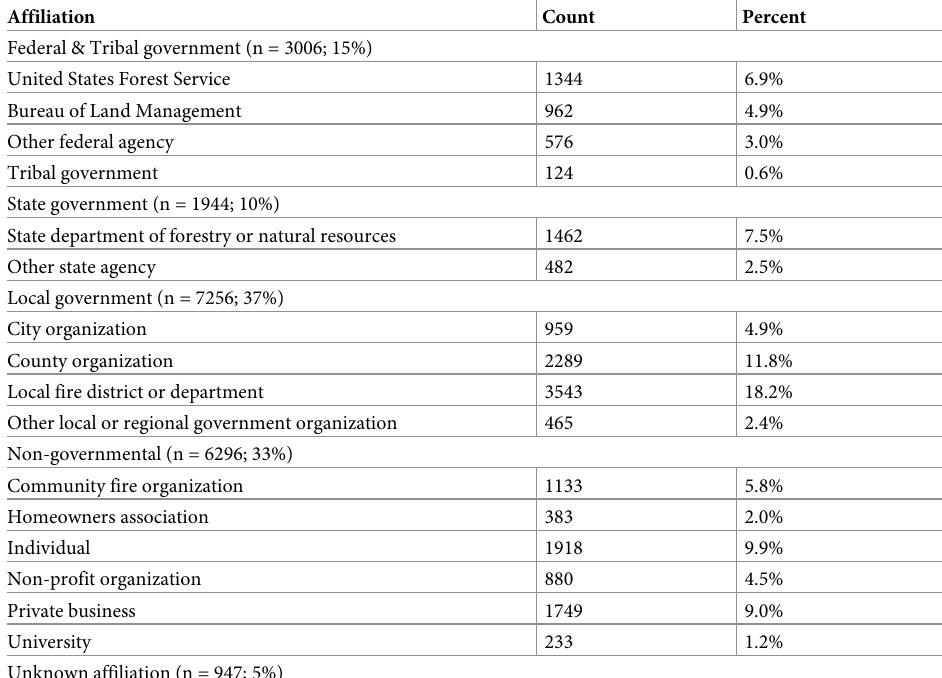
Table 2. Organizational diversity in CWPPs based on affiliation group (n =